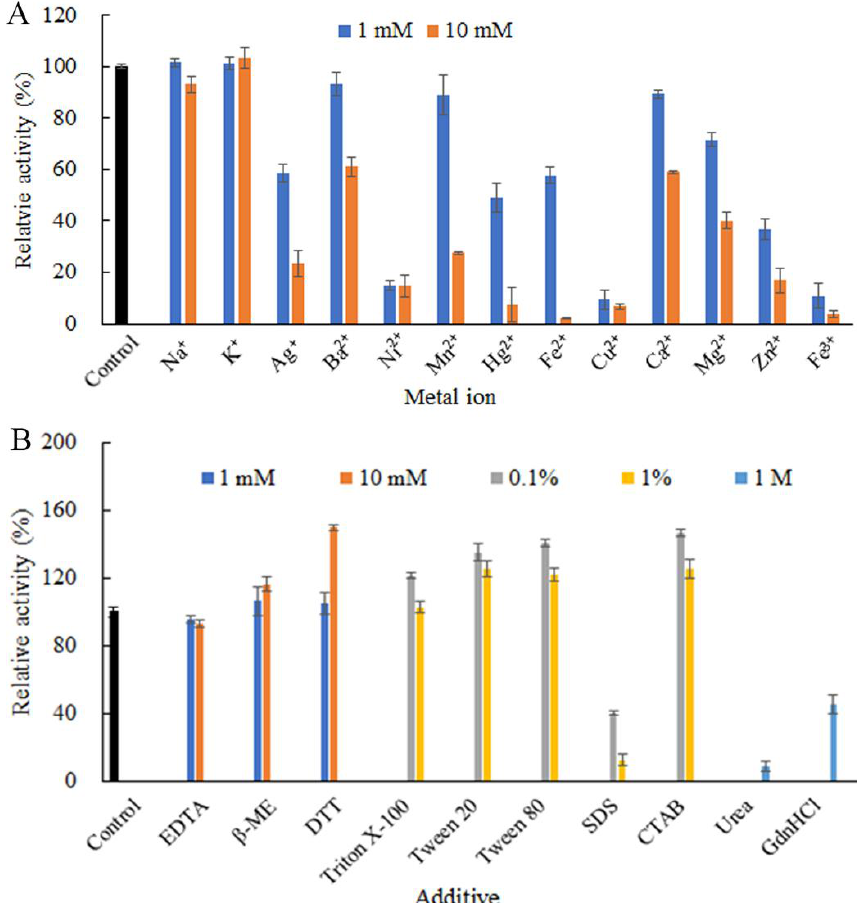
Figure 4. Effects of chemical additives on the stability of ChSase B6. ( A ) Effects of metal ions on the recombinant ChSase B6 stability; ( B ) effects of chelating agents, reducing reagents, surfactants, and denaturants on ChSase B6 stability. Values are mean ± SD from three independent experiments.